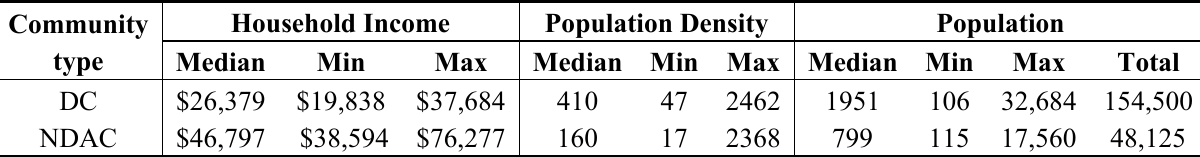
Table 2. US Census Bureau 2000 Annual Household Income (USD yr − 1 ) and 2010 Population Census Data for all DCs and NDACs. DC: developing community; NDAC: non-disadvantaged